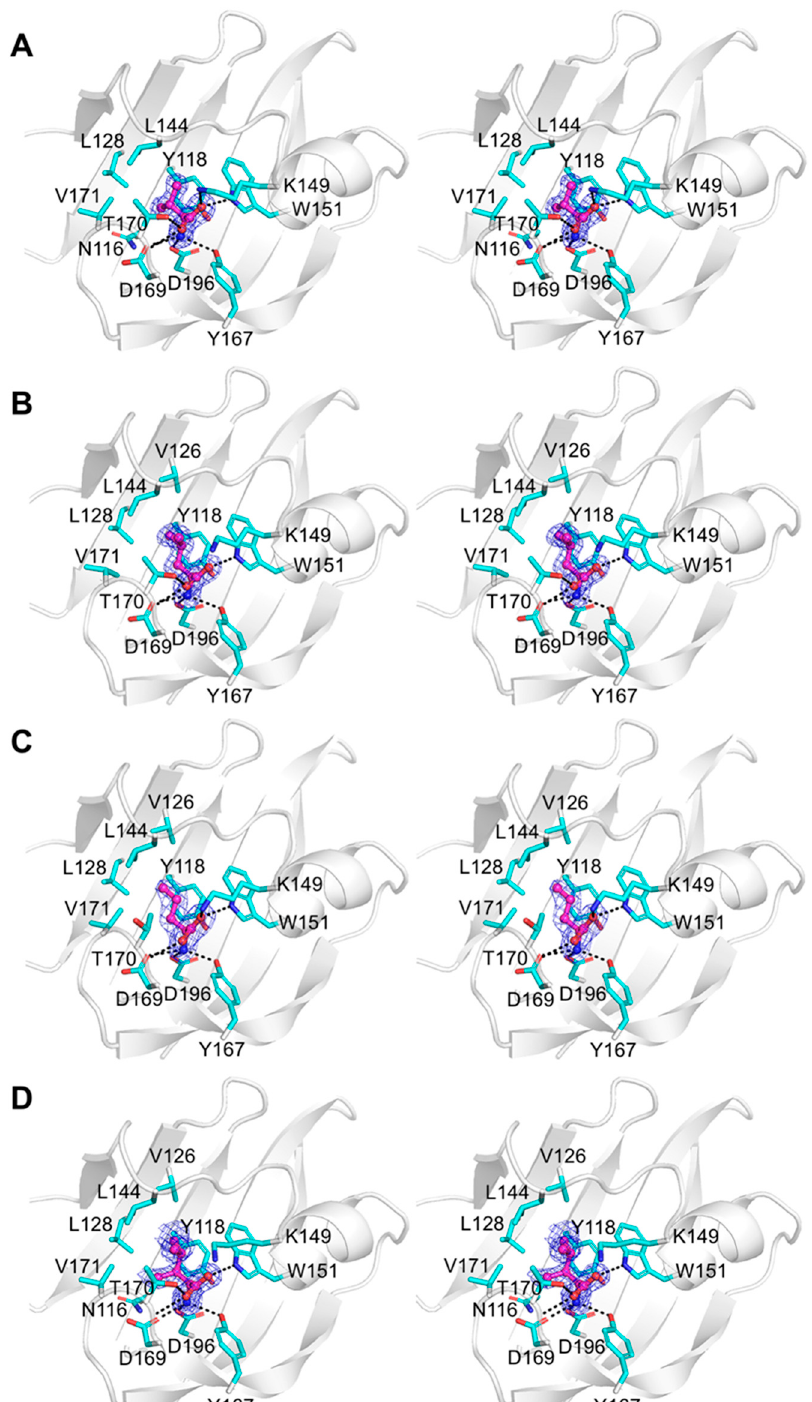
Figure 5. Close-up stereoview showing simulated annealing composite omit electron density for amino acids bound to membrane-distal subdomain of Tlp3 LBD in respective complexes with: ( A ) L-valine, ( B ) L-leucine, ( C ) α -amino-N-valeric acid, and ( D ) 4-methyl-L-isoleucine. The ligand molecules are shown in all-atom ball-and-stick representation with C atoms coloured purple. The protein side chains that form direct contacts with the ligands are shown in stick representation. The map was contoured at the 1.0 σ level.